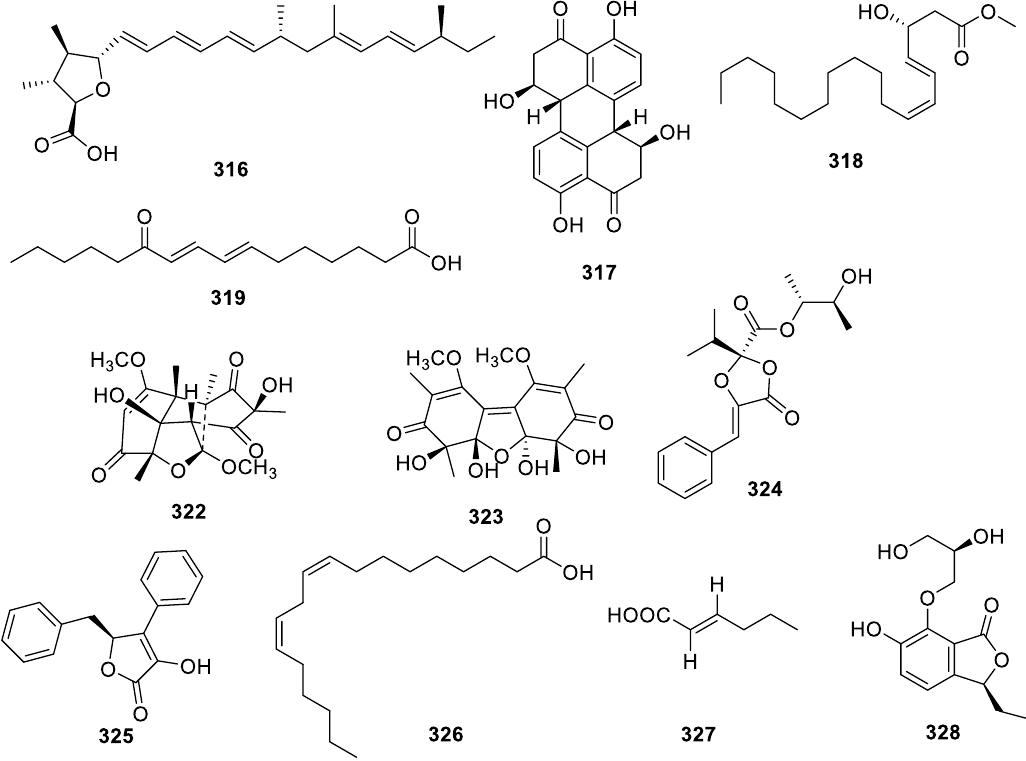
Figure 13. Chemical structures of other polyketides ( 316 – 319 , and 322 – 328 ).